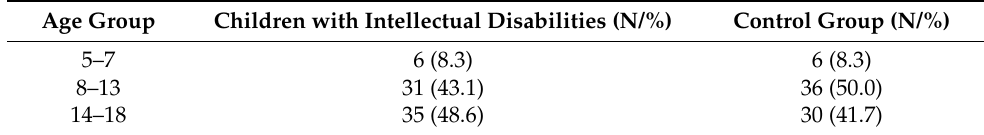
Table 2. Age distribution of examined